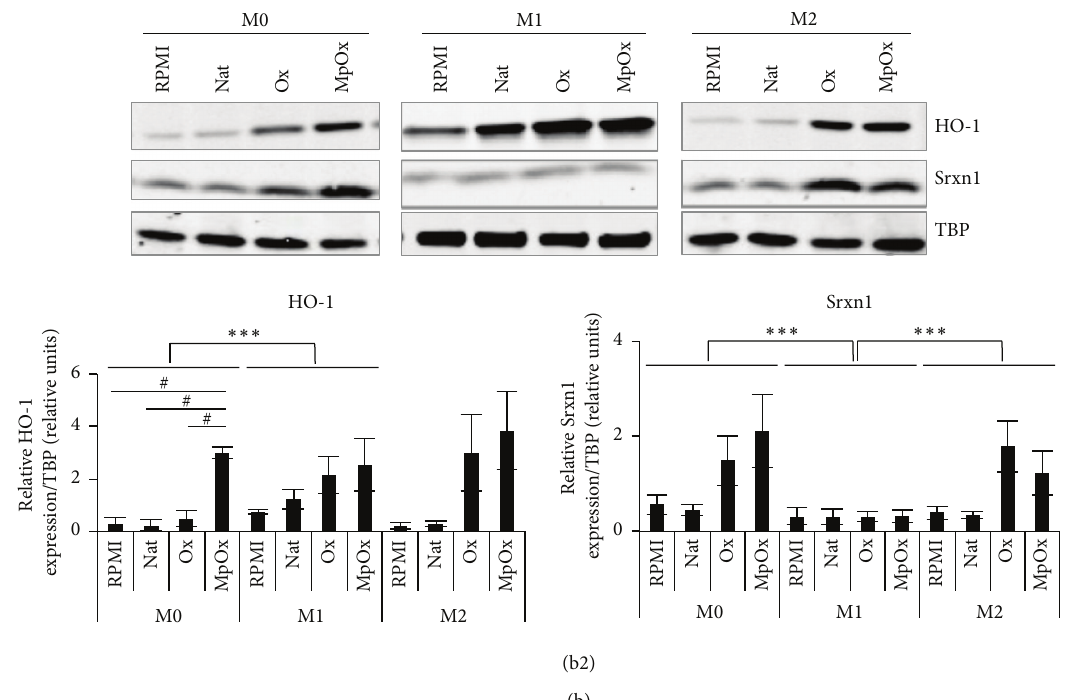
Figure 4: Comparative effects of LDLs on (un)polarized RAW 264.7 macrophages. M0, M1, and M2 macrophages were stimulated in the presenceorabsence(RPMIcontrol)ofNat-LDLs,Ox-LDLs,andMpOx-LDLsfor24hours(100 𝜇 g/mL).(a)Expressionofpolarizationmarker genes at the mRNA level (RT-qPCR). The expression of marker genes was analyzed by RT-qPCR as described in Figure 1. Data are normalized with TBP used as housekeeping gene and expressed as mean fold induction relatively to M0 cells in RPMI ± SD ( 𝑛 = 6 ). Data for MRC1 were analyzed by a Kruskal-Wallis ANOVA on ranks. Zoomed data for Arg1 and MRC1 are presented in Figure S5. (b). Expression of polarization marker genes at the protein level (ELISA; WB). (b1) Production of secreted IL-6 (M1 marker) in cell culture supernatants assessed by ELISA. Data are expressed relatively per 𝜇 g of protein per well as mean ± SD ( 𝑛 = 3 ). (b2) Expression of HO-1 and Srxn1 assessed by Western blotting. Data are normalized with TBP used as loading control and expressed as mean ± SD ( 𝑛 = 3 ). Results are representative of 3 independent experiments. ANOVA 2: ∗, # 𝑝 < 0.05 ; ∗∗, ## 𝑝 < 0.01 ; and ∗∗∗, ### 𝑝 < 0.001